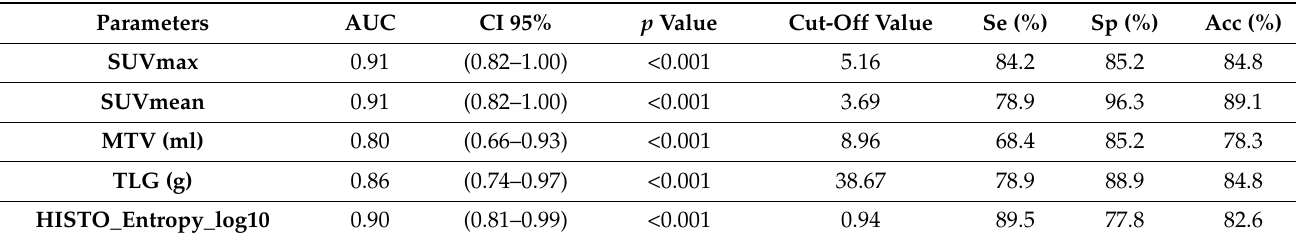
Table 3. Diagnostic performance of conventional and volumetric PET parameters and HISTO_Entropy_log10 in NECs versus NETs.